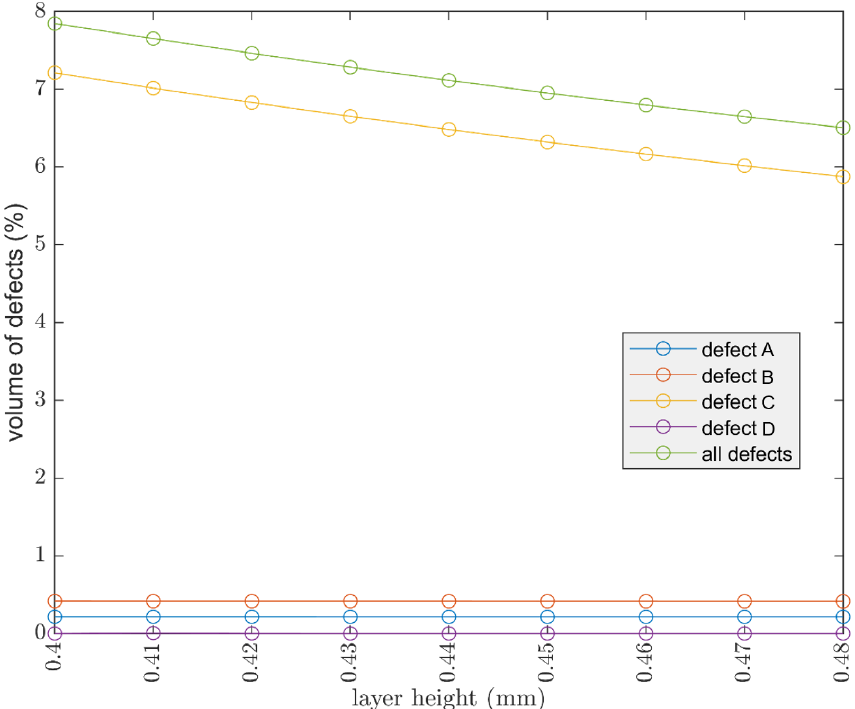
Figure 10. Influence of width (considering 2 shell (contour) lines, raster angle 45 ◦ , nozzle 0.4 mm, layer height 0.15 mm).